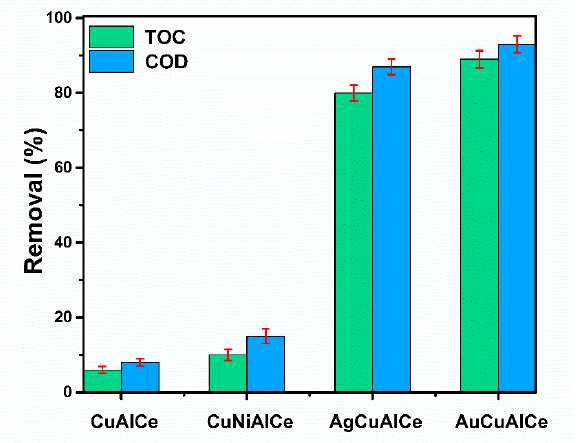
Figure 17. COD and TOC removal efficiency of monometallic CuAlCe and bimetallic catalysts NiCuAlCe, AuCuAlCe, AgCuAlCe obtained after 180 min of reaction. Operation conditions T = 120 °C, P(O 2 ) = 10 bar, V Liq = 0.25 L, Cfenol = 1000 mg L − 1 , C Cat = 1 g L − 1 , ω = 1000 rpm.